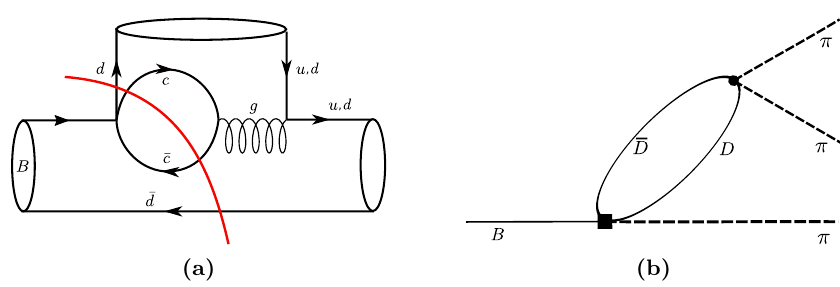
Figure 1. (a) Sketch of color-octet contribution in QCD factorization, where the blobs correspond a single or two-pion states. (b) Example of a mesonic diagram corresponding to